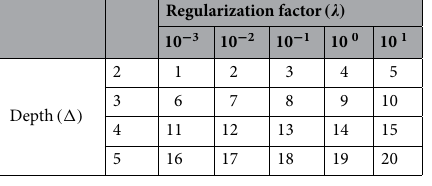
Regularization factor ( (cid:31)